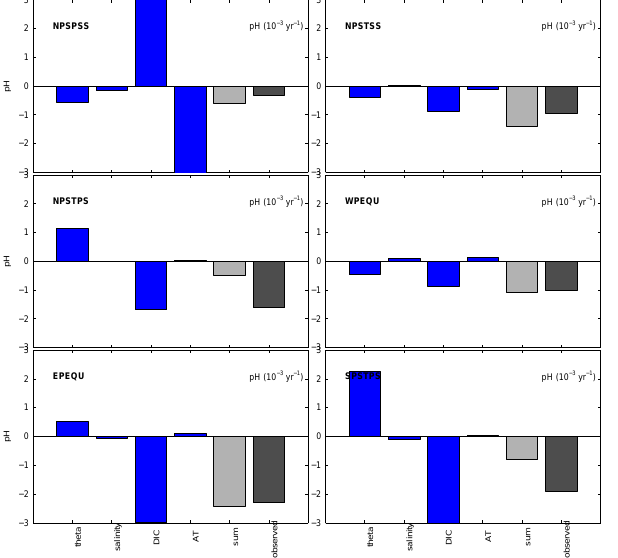
Figure 8. The long-term trends in pH from Fig. 3 decomposed into the contributions from SST, SSS, alkalinity, and DIC. Also shown is the sum of the four contributions and the actual observed trend. Note that the trend has been multiplied by 1000 for easier visualization.